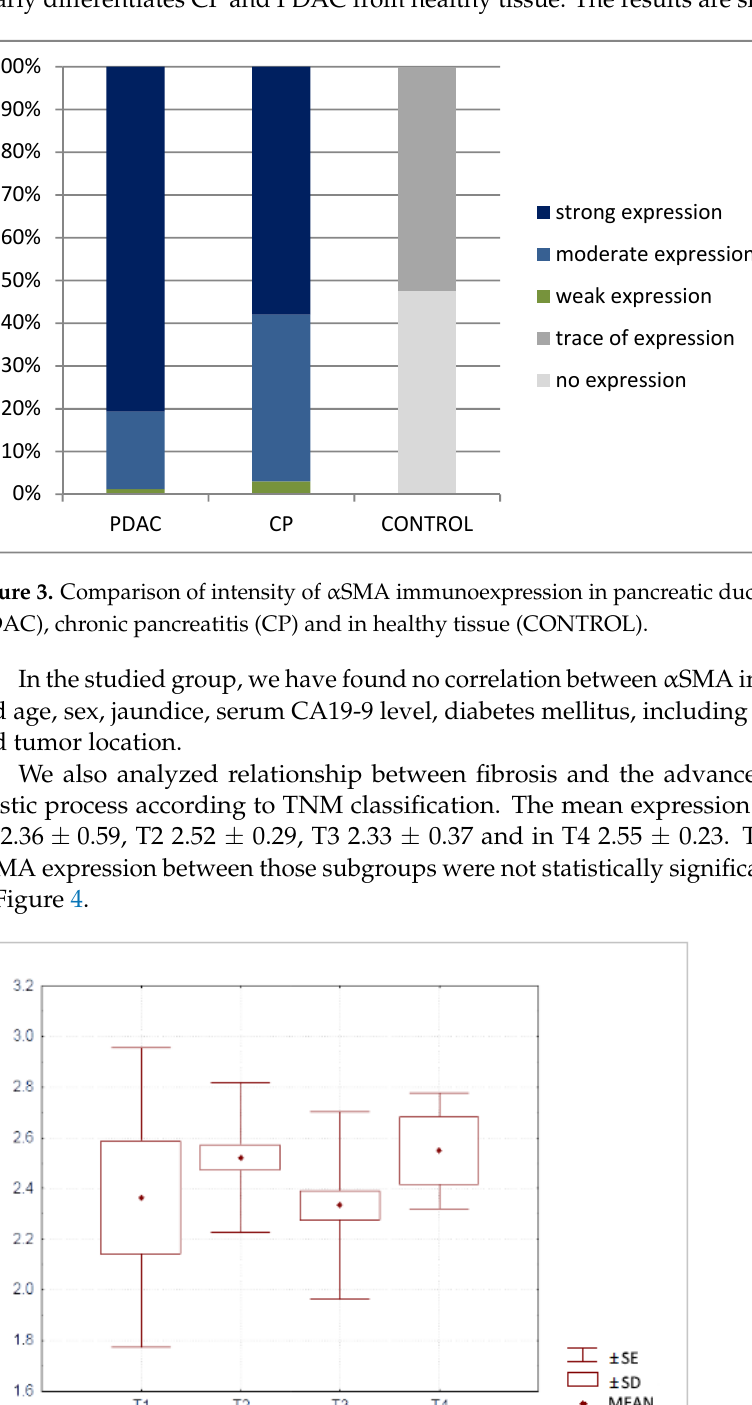
Figure 2. Comparison of α SMA expression in pancreatic ductal adenocarcinoma (PDAC), chronic pancreatitis (CP) and in healthy tissue (CONTROL).